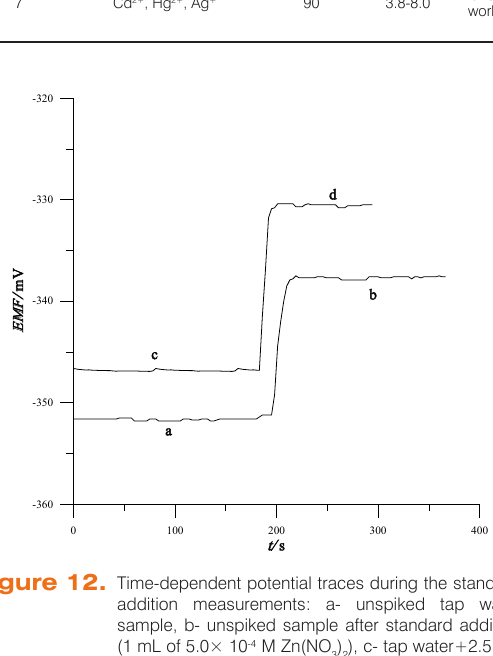
) ), c- tap water+2.5 µM 3 2 ) ). Background 1.0× 10 -3 3 2